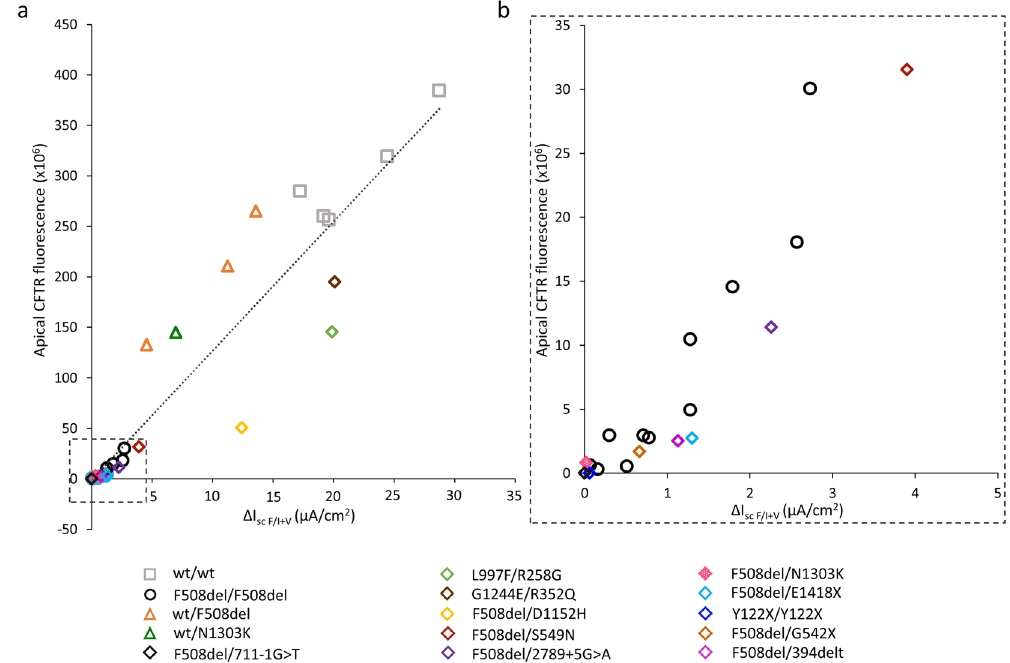
Figure 2. Correlation between cAMP dependent chloride transport and apical CFTR expression in HNE cells according to genotype. cAMP-dependent chloride transport is expressed as the I sc response ( ∆ I sc ) to Forskolin (10 µ M)/IBMX (100 µ M) + VX-770 (10 µ M) ( ∆ I scF/I + V ). The apical CFTR staining is expressed as the apical CFTR fluorescence (average corrected apical fluorescence multiplied by the percentage of cells with apical staining). The intensity of fluorescence was evaluated in the apical zone of epithelial cells and the region outside the cells for background correction in at least 3 cells from 3 random fields. Data from 5 wt/wt control subjects, 11 F508del/F508del patients, 3 wt/F508del ( + 1 wt/N1303K) heterozygotes, and 11 patients with other genotypes (legend in the figure). The dotted line shows simple regression analysis of the data ( R 2 = 0.9, p < 0.0001). ( a ) Correlation graph representing all data. ( b ) Inset for patients with ∆ I scF/I + V below 5 µ A/cm 2 . Inset shown in graph ( a ) by dashed line